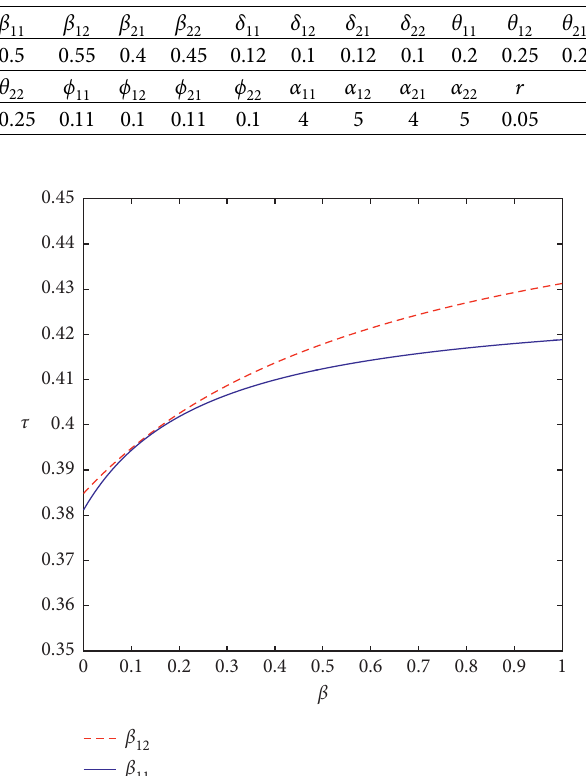
Figure 1: The relationship between the ecological compensation rate and green innovation investment cost coefficient.